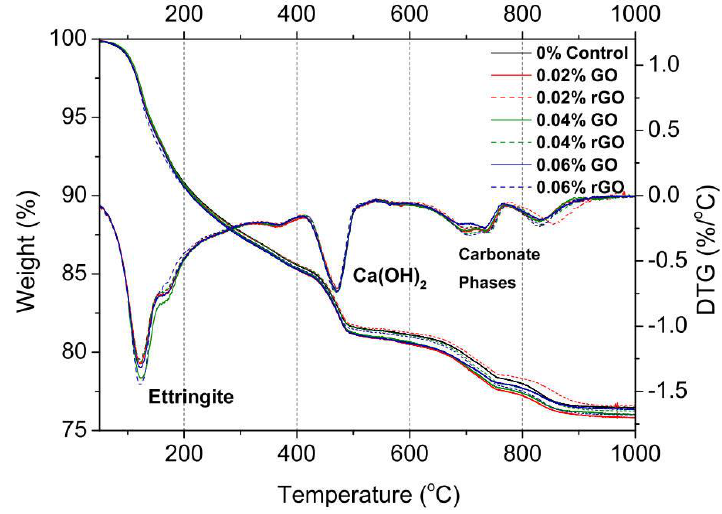
Figure 10. TGA and DTG curves for GO or rGO reinforced CCMs at 28 days. Reprinted with permission from Ref. [93]. Copyright 2019 Elsevier.